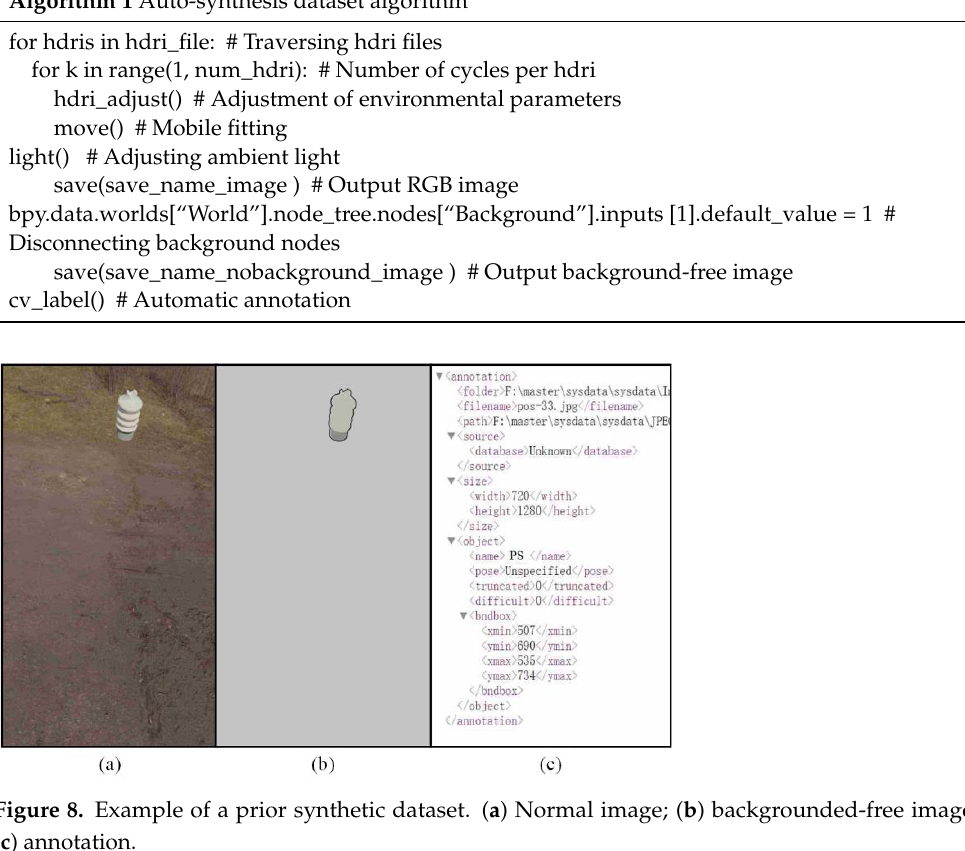
Figure 9. YOLOv5 network structure. The input includes self-adaptive image scaling, Mosaic data enhancement, and self- adaptive anchor box calculation. Different images are scaled to fixed size by self-adaptive image scaling with normalization. The Mosaic data enhancement uses four images and stitches them together in a randomly scaled, cropped, and matched manner. This enhance- ment method can combine several images into one, enriching the dataset and improving the training speed of the model. Meanwhile, it could reduce the memory requirement of the model. The backbone benchmark network is usually some high-performance classifier to ex- tract general features. The CSPDarknet53 structure is introduced into the backbone, and the focus structure is used as the backbone to crop the input image by slice operation and